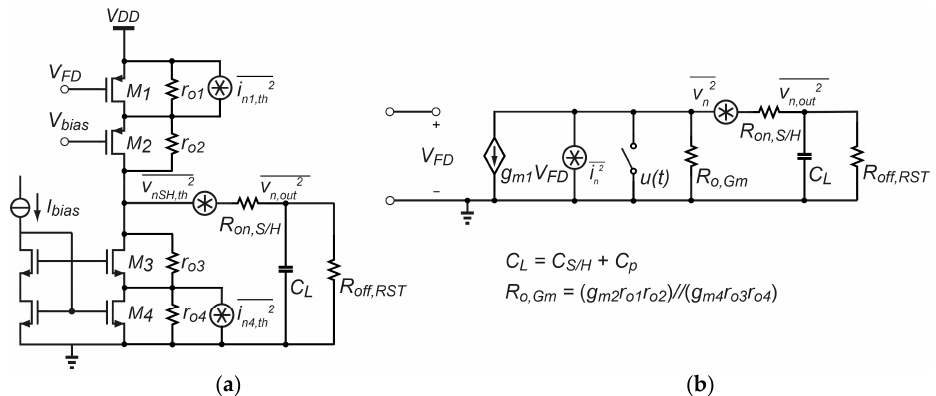
Figure 6. ( a ) Noise model ( b ) Small signal model of Gm-cell-based pixel.